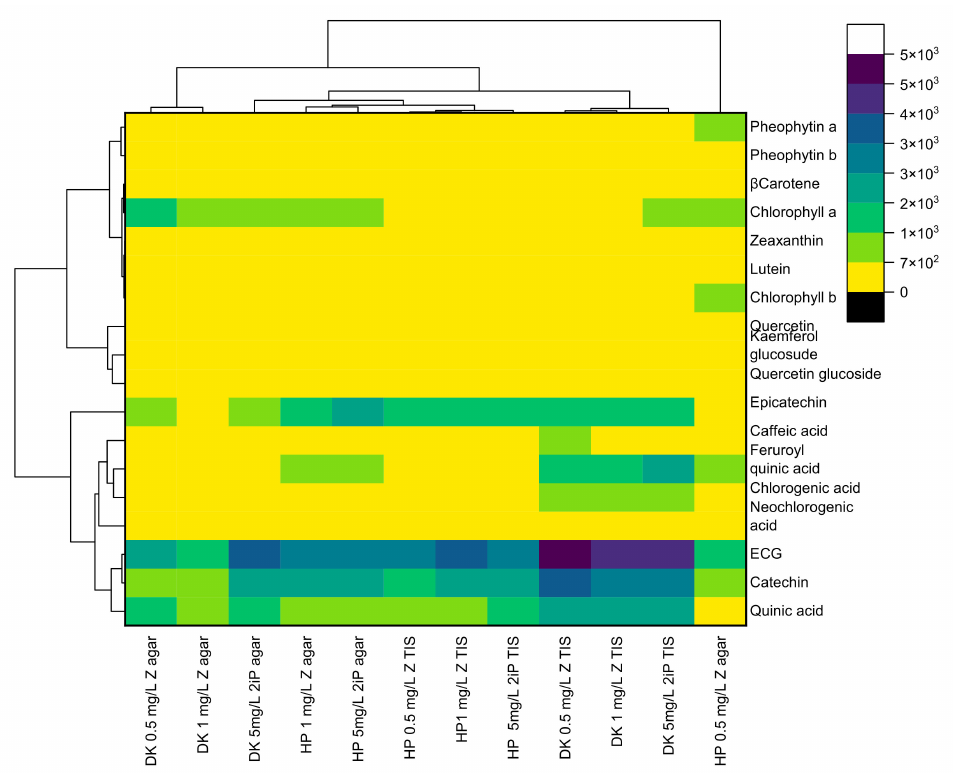
Figure 4. Heat map showing the content of individual phenolic, carotenoid and chlorophyll compounds in the shoot extracts of the two highbush blueberry varieties (DK—Duke, and HP— Hortblue Petite), on two types of culture systems (solid medium/5 g/L Plant agar and liquid medium/Plantform bioreactor) and three variation of growth regulators (0.5 mg/L and 1 mg/L zeatin and 5 mg/L N6-(2-Isopentenyl) adenine). A yellow box indicates the chemical compounds’ content was lower than the average level, and a blue box indicates the chemical compounds’ content was higher than the average